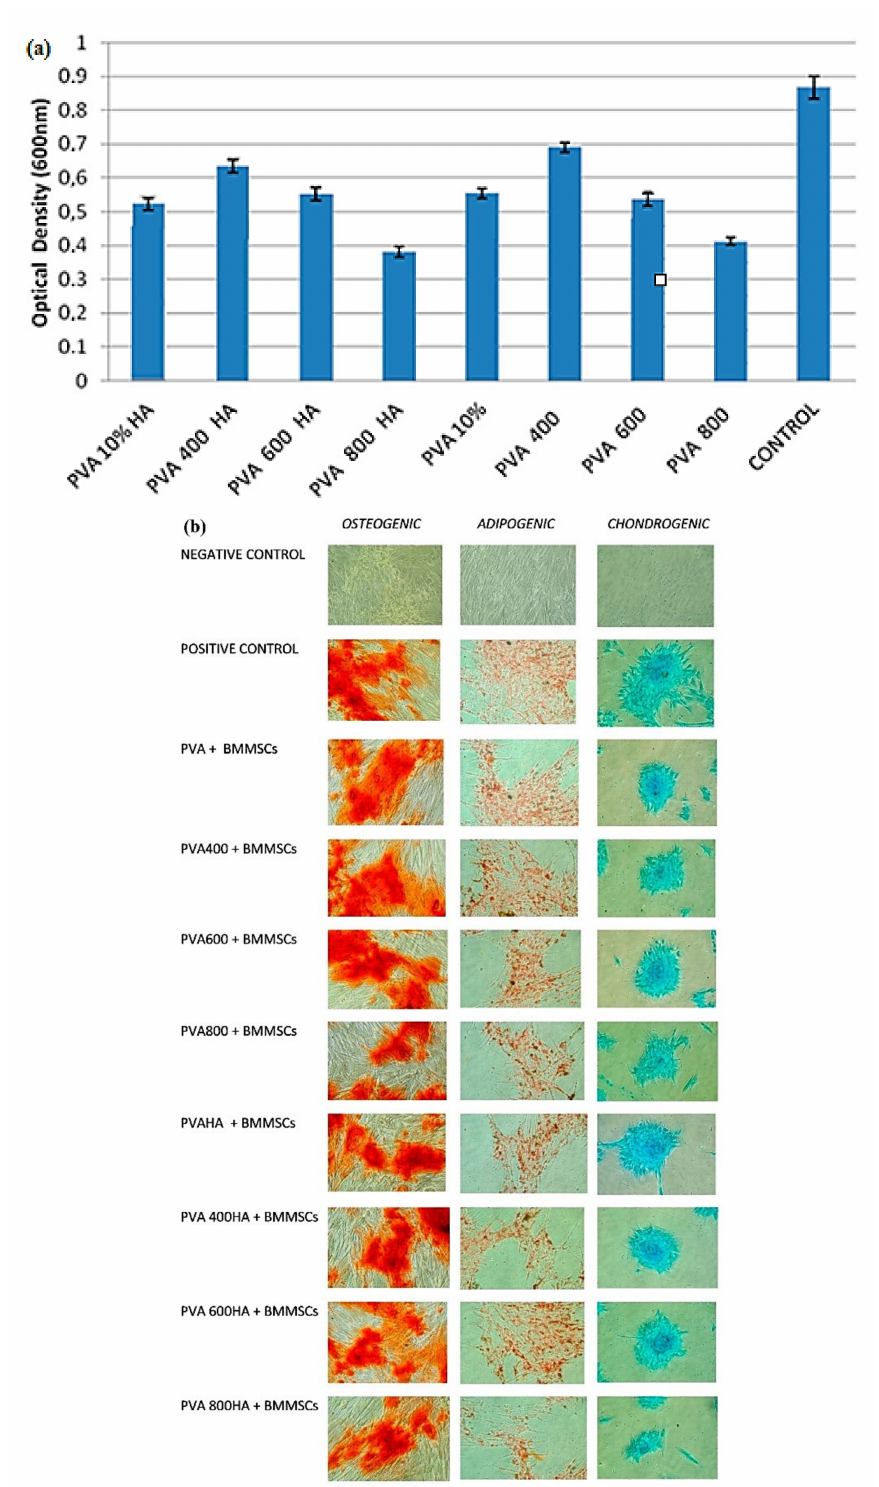
Figure 10. Hydrogels based on PVA/Se-doped TiO 2 NPs/HA [164] ( a ) MTT assay of BMMSCs with PVA-based composites after 72 h incubation, and ( b ) Differentiation potential of BMMSCs to osteogenic, adipogenic, and chondrogenic lineages, of PVA nanocomposites after 72 h of